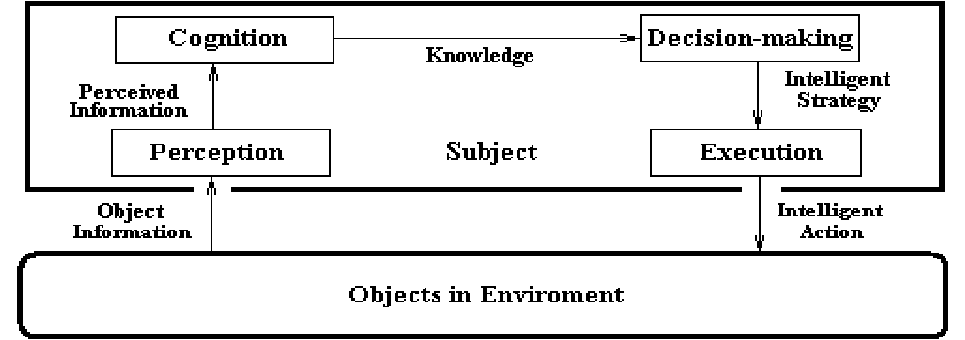
Figure 1. Model of Ecological Process in Information